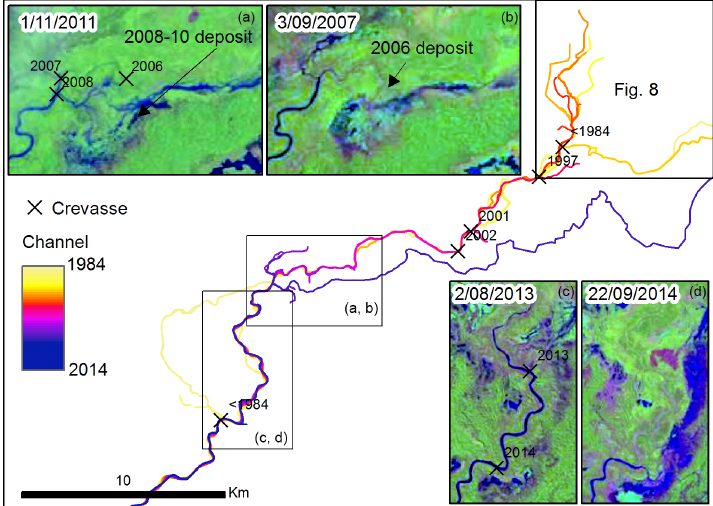
Figure 7. The Río Maniqui. Insets (a) and (b) show crevasse splay deposits which are immediately covered with vegetation. Insets (c) and (d) show the backward movement of the crevasse point and the sudden collapse of the original channel. The blue area to the right of inset (d) is a depression that has been flooded because of the crevasse opened in 2014. After the crevasse of 2008 the river avulsed and took a new course, but the new course lasted only until the crevasses of 2013 and 2014 (insets c and d ) re-established the backward